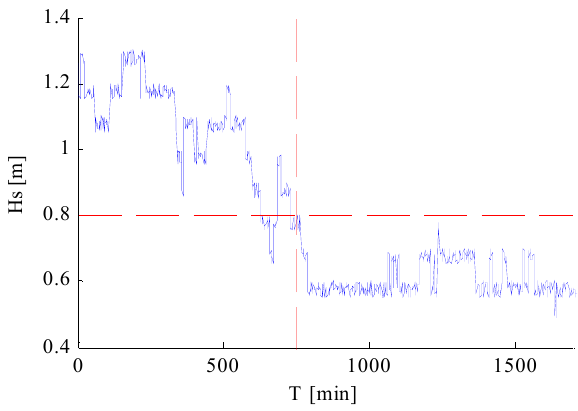
Figure 6. Real-time significant wave Figure 6. Real - time significant wave heights. Figure 6. Real - time significant wave heights.